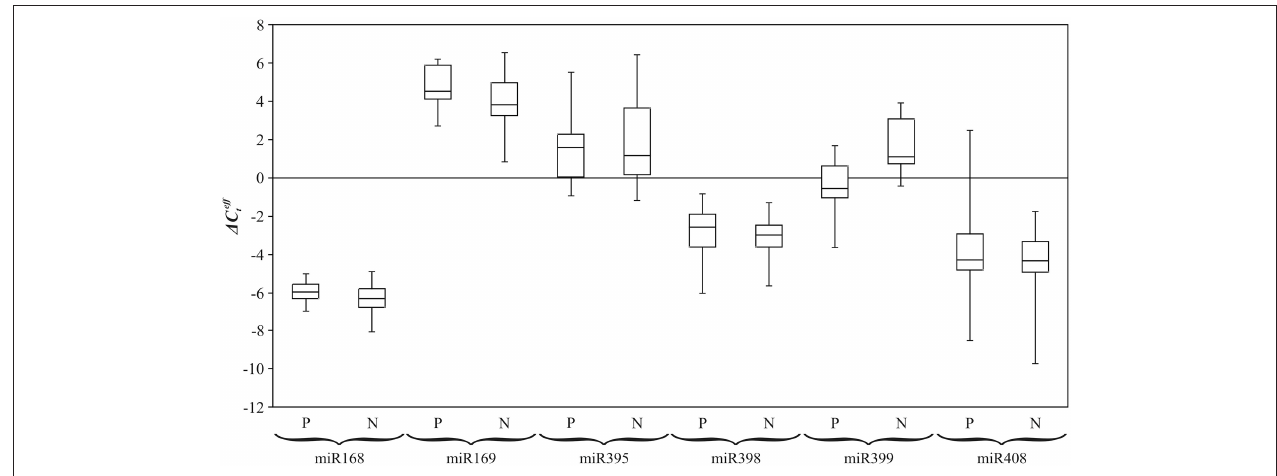
FIGURE 5 | Expression level ( 1 C eff t ) of flax miRNA families under Pi deficiency (P) and normal (N) conditions. QPCR data. Rectangles correspond to the ranges containing 50% of the values (between the 25th and 75th quartiles); the horizontal line inside the rectangle is the median value (the 50th percentile); the bars are the maximum and minimum 1 C eff t values.